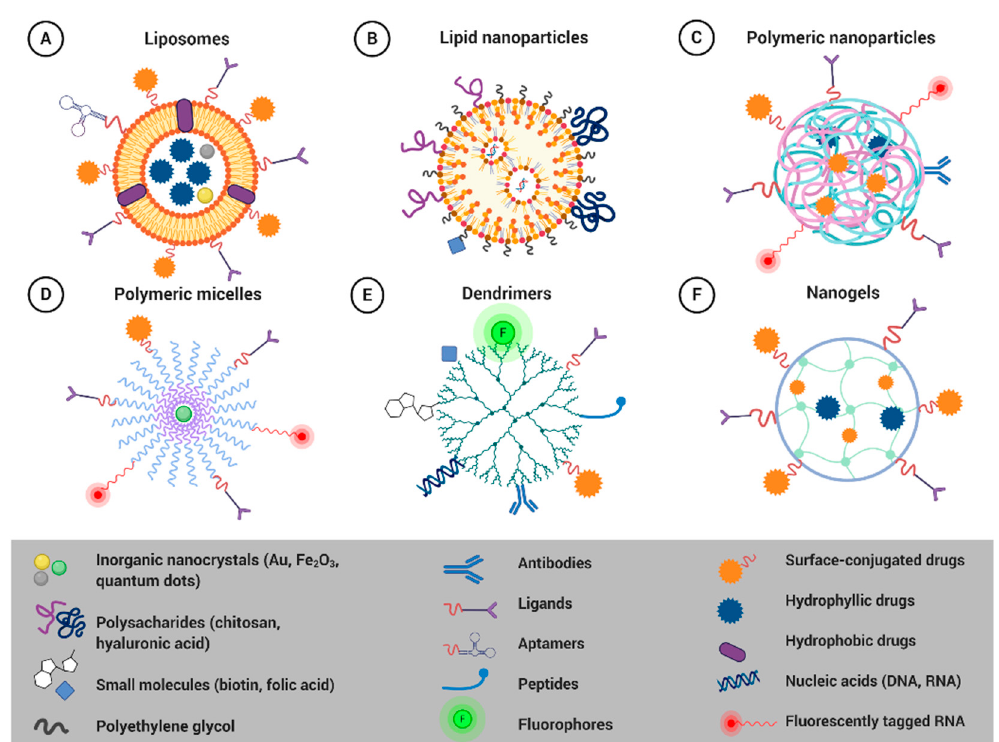
Figure 2. Main types of soft nanocarriers for drug delivery. Schematic examples of surface modifications and functionalization.